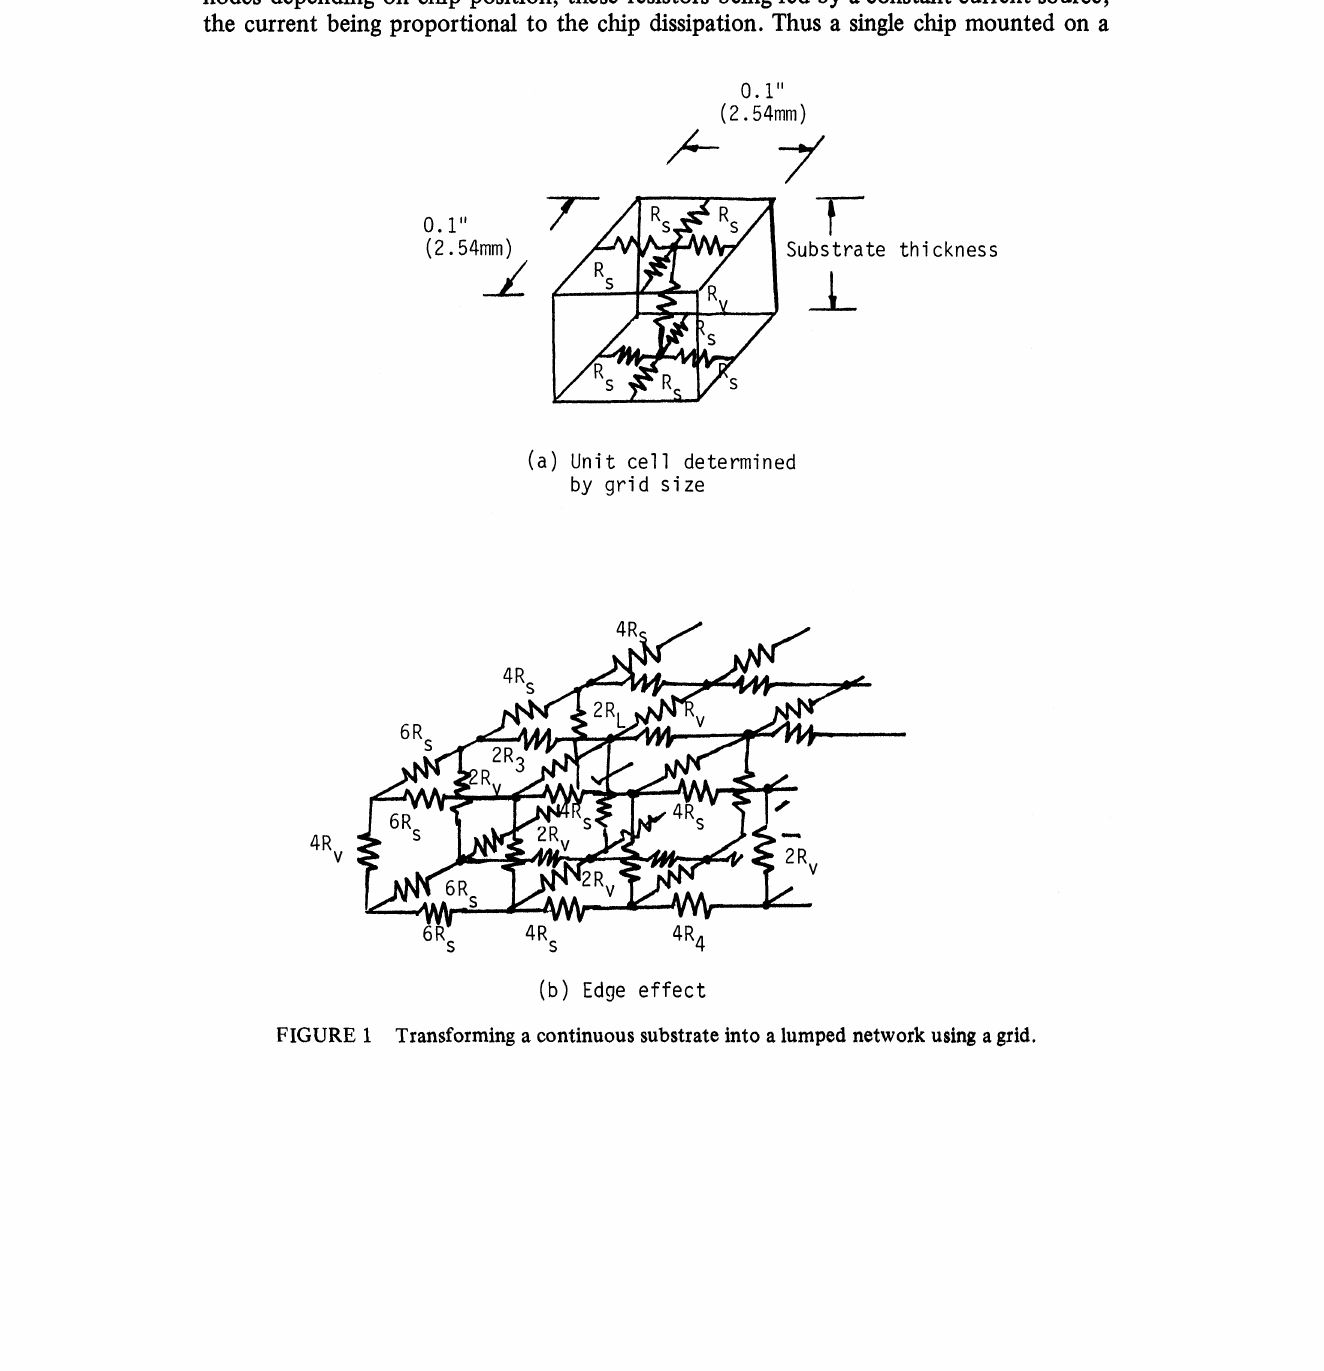
FIGURE Transforming a continuous substrate into a lumped network using a